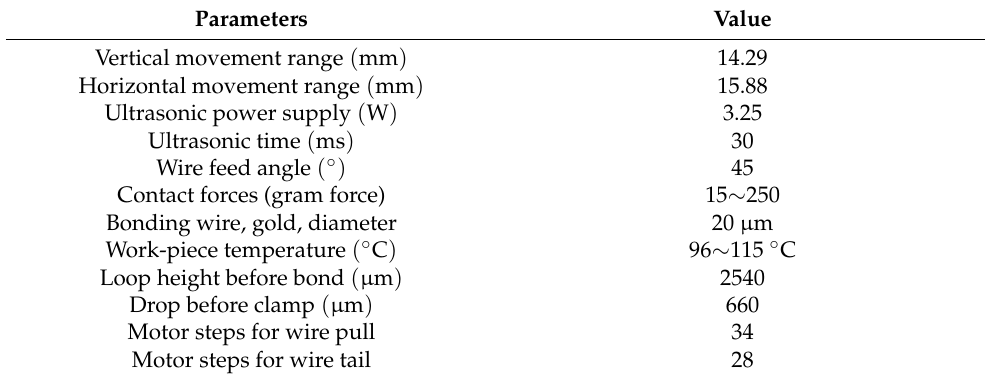
Figure 11. ( a ) Gold wires connecting sensors to the PCB pads, ( b ) a magnified view of a PolyMUMPs sensor wire bonded to PCB pads. Table 5. The parameters of the WEST BOND 7700E wire-bonding